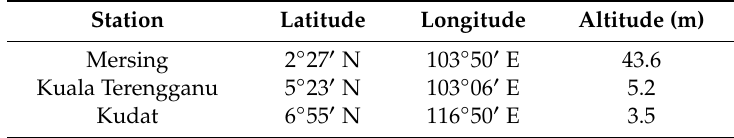
Figure 4. Wind speed distribution maps for station sites used in this study in Malaysia. Table 1. Description of the wind speed stations at selected regions in Malaysia.